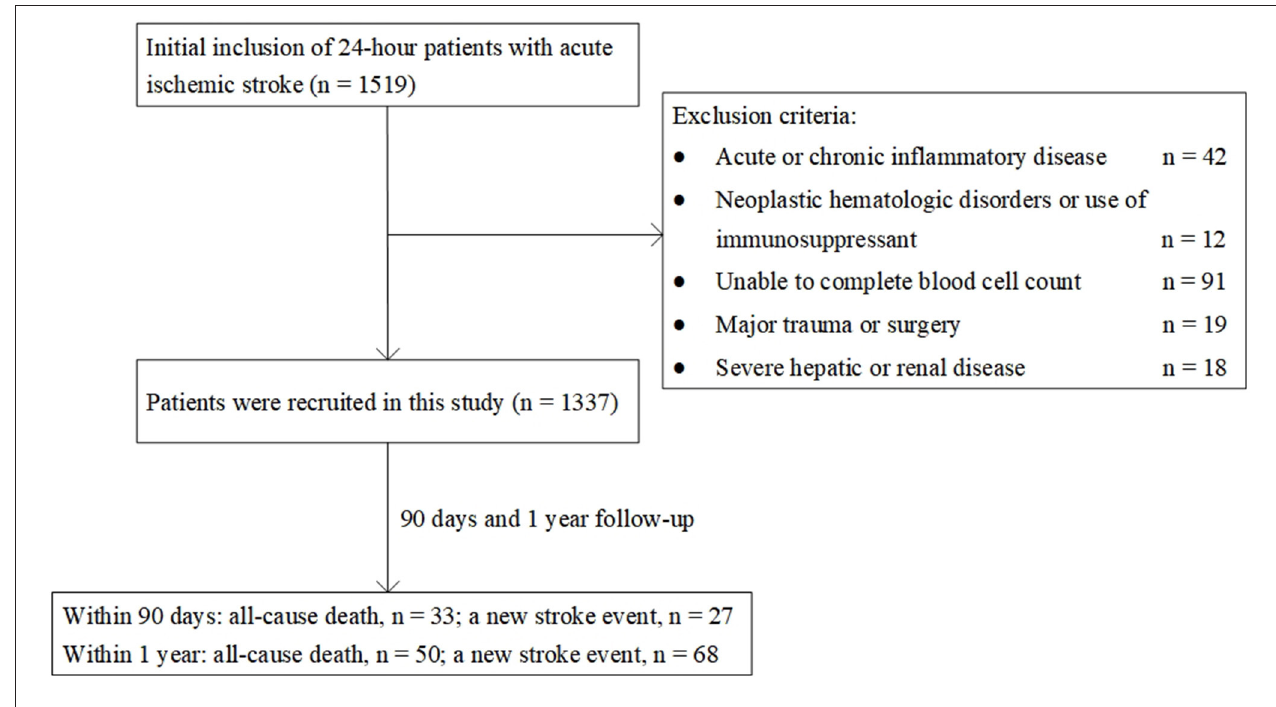
FIGURE 1 | Patient flowchart of the cohort. TABLE 1 | Baseline characteristics of patients according to the HALP score